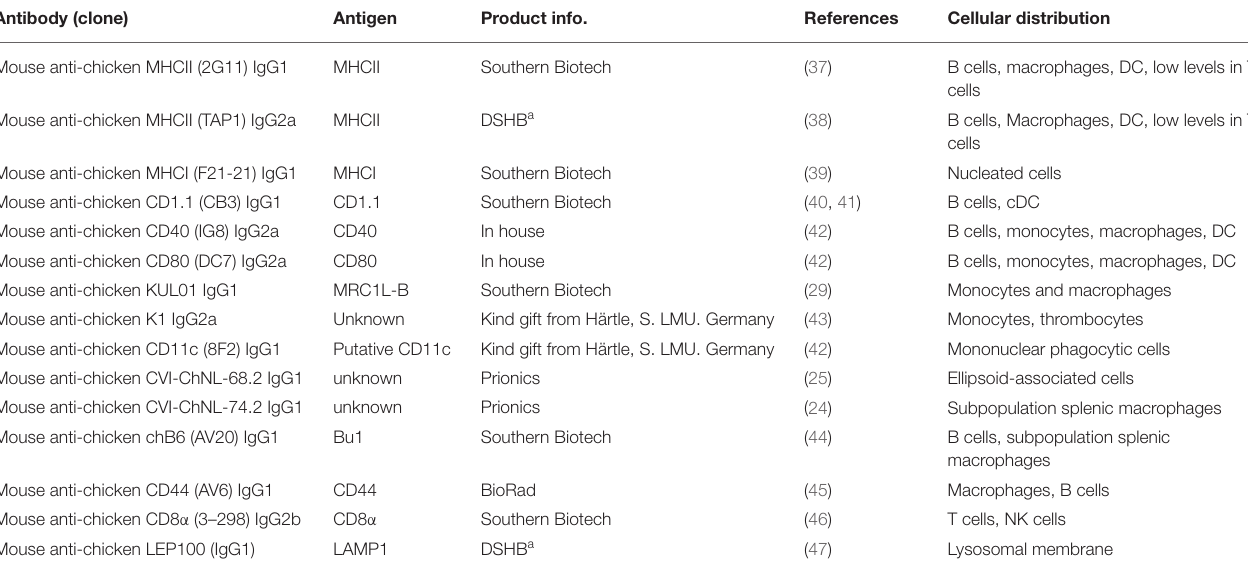
TABLE 1 | Antibodies used for confocal microscopy and flow cytometry analysis. Antibody (clone) Antigen Product info. Cellular